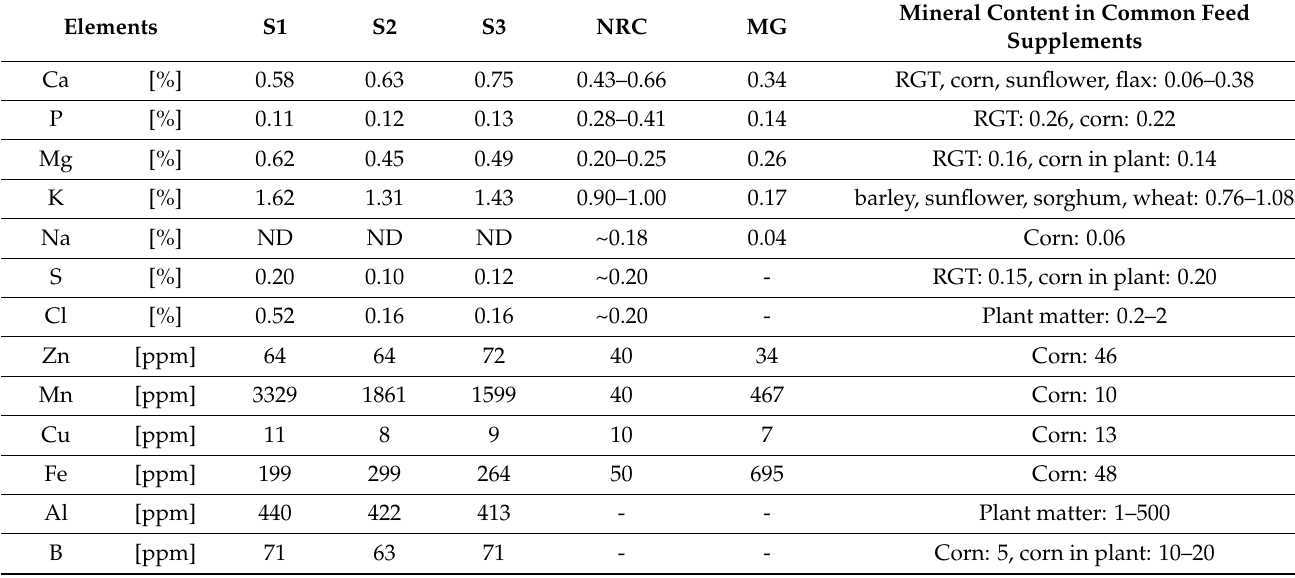
Table 3. Mineral content in IP , NRC recommendations, and alternative livestock feed supplements.